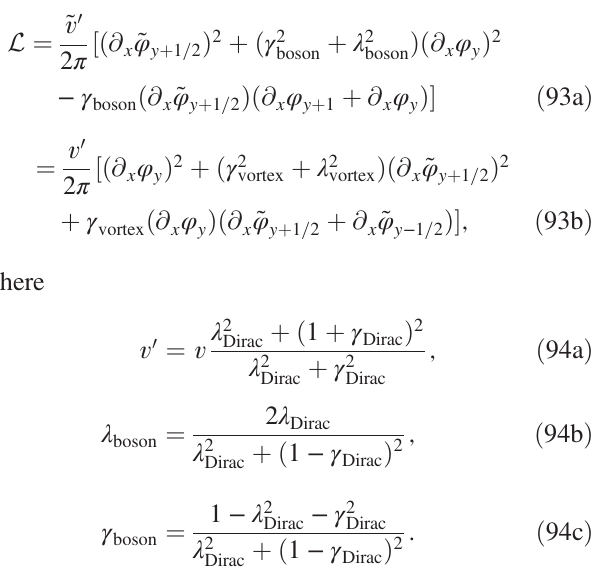
TABLE II. Gapped fermion phases and their bosonic duals can be characterized by their bulk electromagnetic response (to the respective total gauge fields seen by the fermions or bosons). Gapped fermions with a quantized Hall response σ fermion xy ¼ (cid:3) e 2 = ð 2 h Þ correspond to boson superfluids and Mott insulators 0 ). Conversely, bosons with a quantized Hall (with σ boson xy ¼ response σ boson